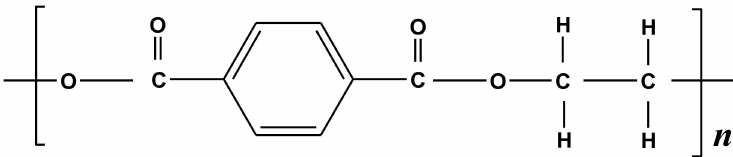
Figure 1. Polyethylene terephthalate (polyester, PET) structural